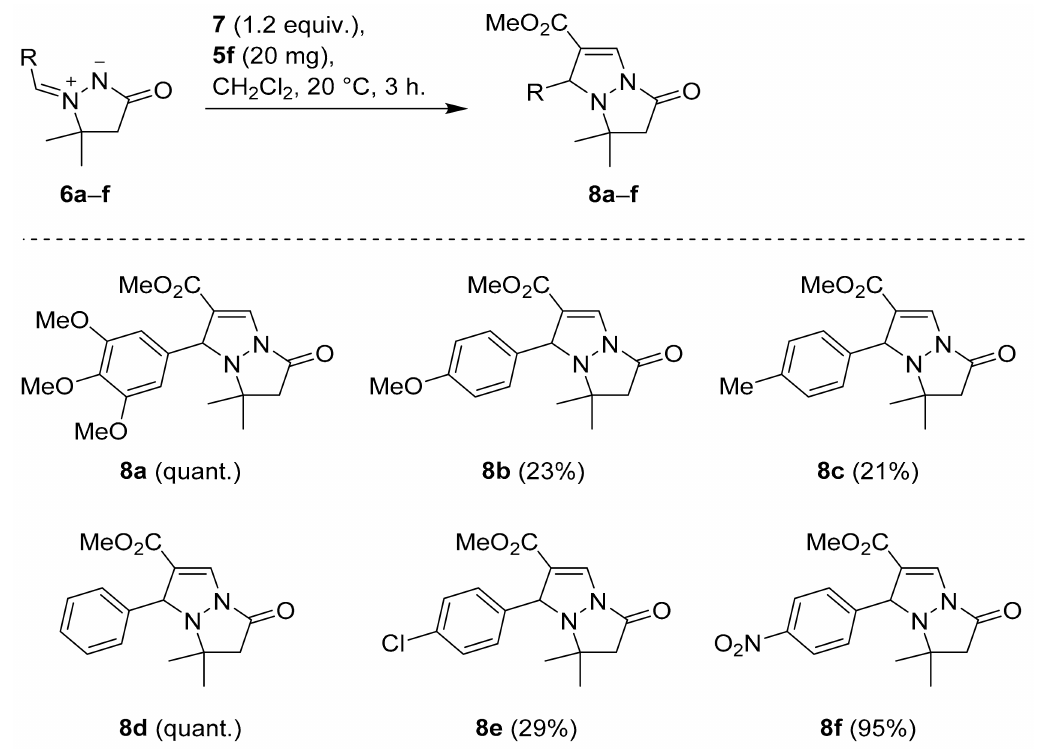
Scheme 2. The conversions in CuAIAC reactions of dipoles 6a – f with methyl propiolate ( 7 ) catalyzed by 20 mg (~13 mol%) of 5f . The conversions were determined by 1 H NMR of the crude reaction